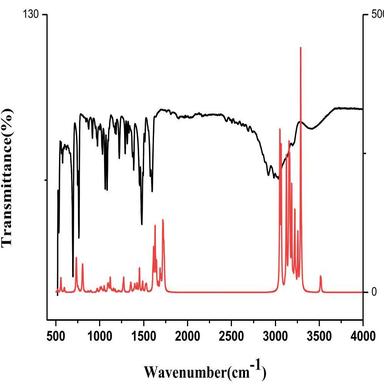
Room temperature experimental (black) and theoretical (red) IR spectra of (C8H12N)42 recorded in the range 4000–500 cm-1.